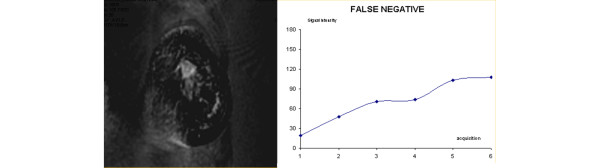
Magnetic resonance mammography of 52-year-old patient who underwent quadrantectomy, adenectomy and radiotherapy for mucinous cancer. This shows a 3 cm rounded lesion with homogeneous contrast enhancement (left image), with the signal–intensity curve showing moderate initial increase and late steady increase (right image). The lesion (Breast Imaging Reporting and Data System II) was mucinous cancer.